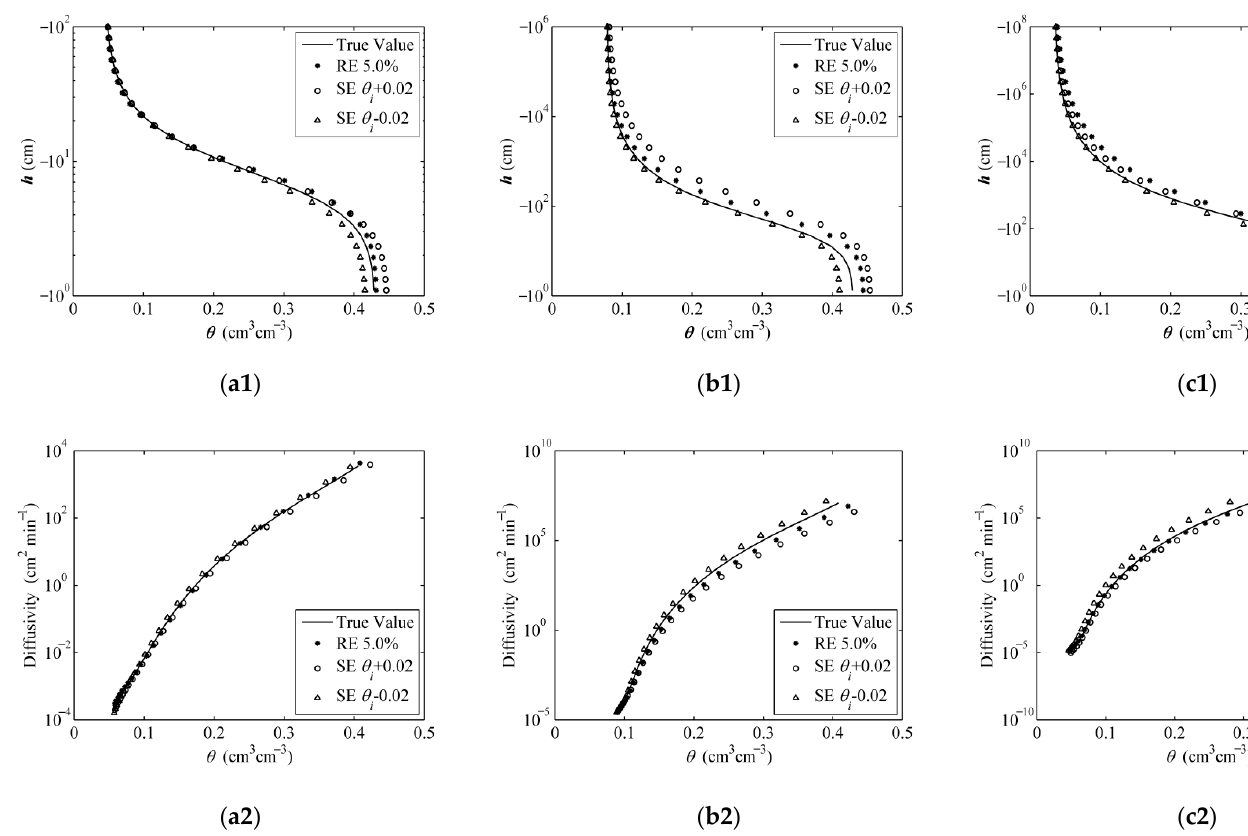
Figure 8. Comparison of SWRCs ( a1 , b1 , c1 , d1 ) and diffusivity curves ( a2 , b2 , c2 , d2 ) with system and random errors for different treatments and calculation using the objective function f ( θ initial ) (circle: 5.0% random error; triangle: 2.0% system error; square: − 2.0% system error; line: true value): ( a ) sand; ( b ) loam; ( c ); silt, and ( d ) clay.